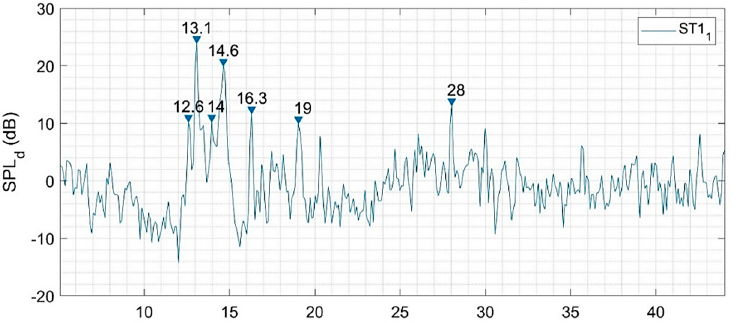
Figure 16. An example graph showing the 12 most significant frequency components in the detrended SPL signal.